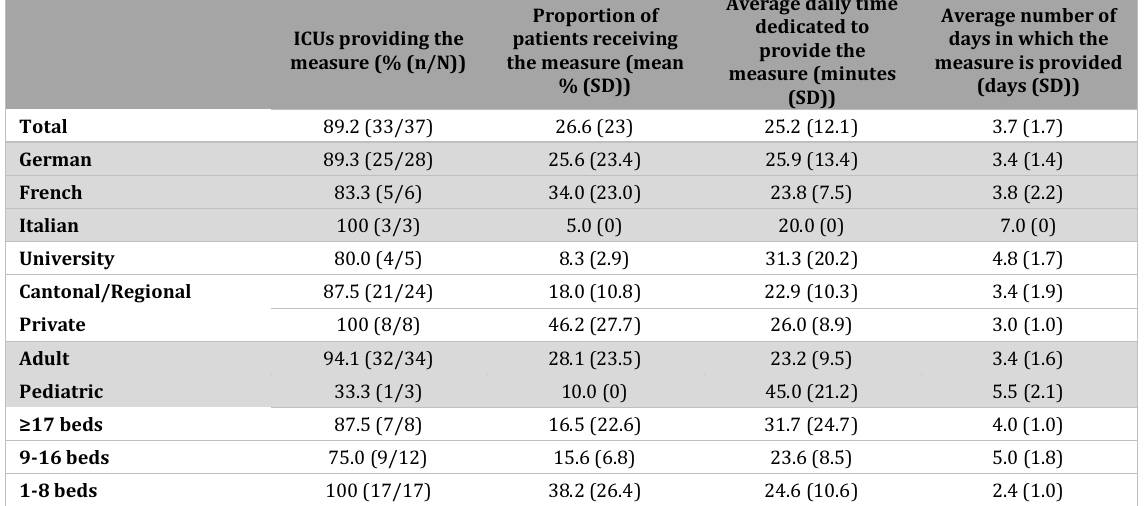
ICUs providing the measure (% (n/N))